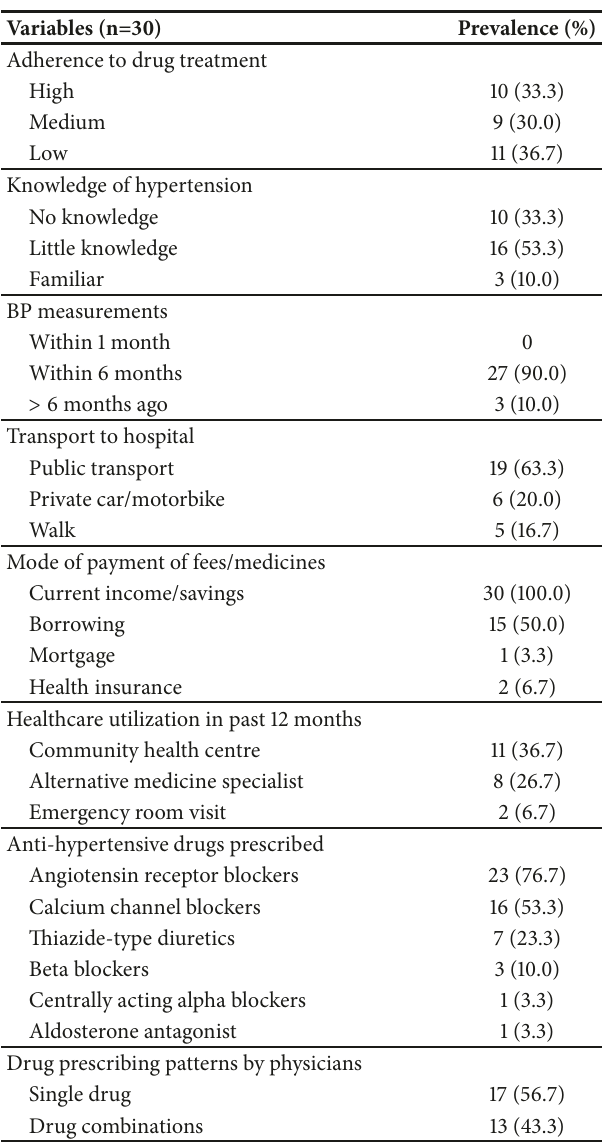
Table 3: Hypertension-specific behavioral